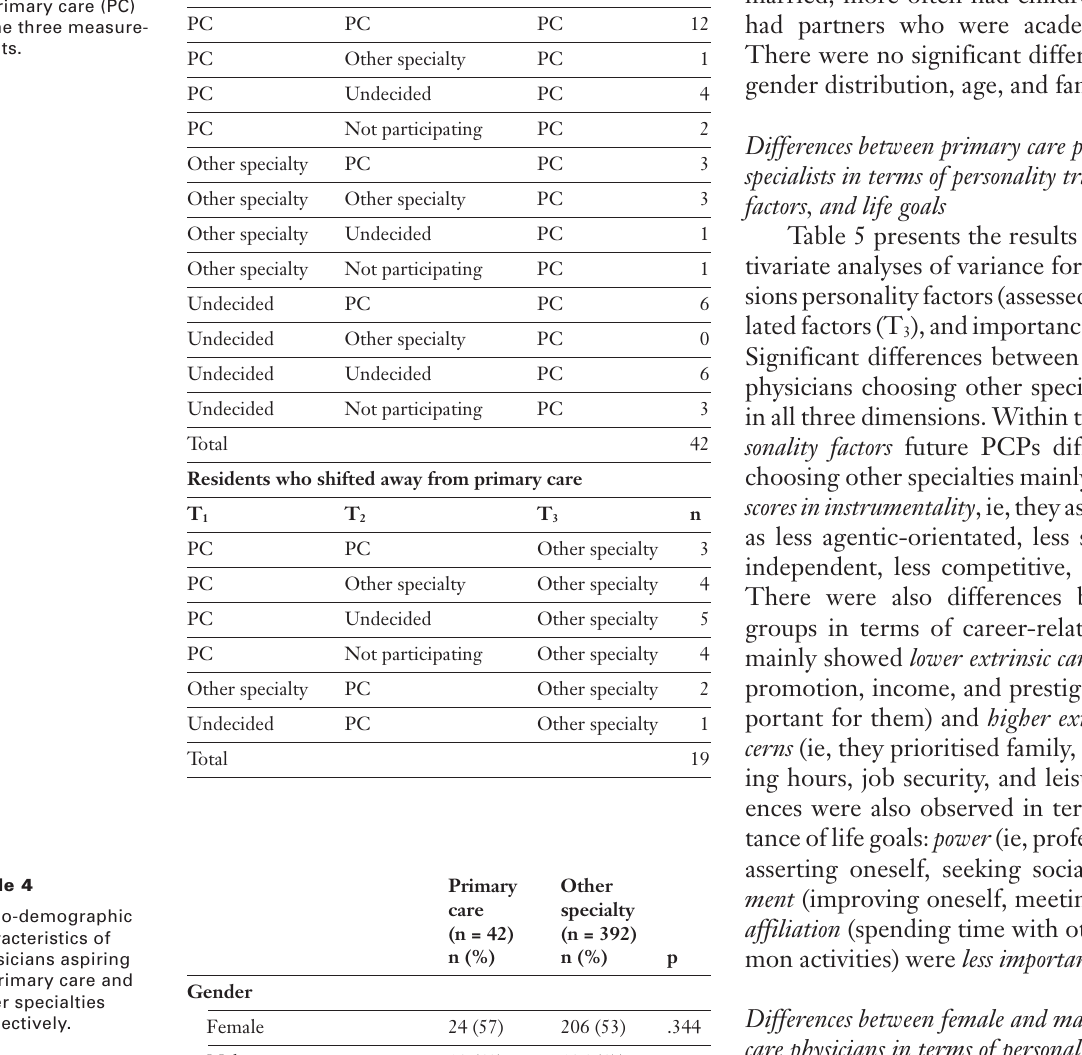
Table 3 Decision to specialise in primary care (PC) at the three measure- ments.